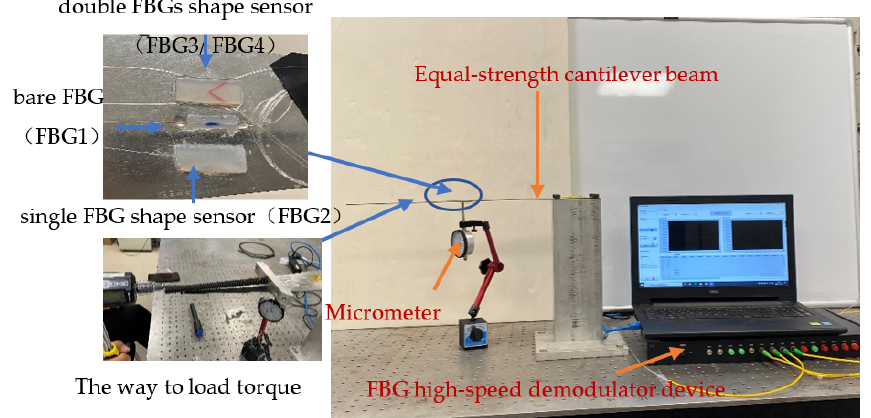
Figure 12. Dual FBG High-Precision Shape Sensor Test Platform.